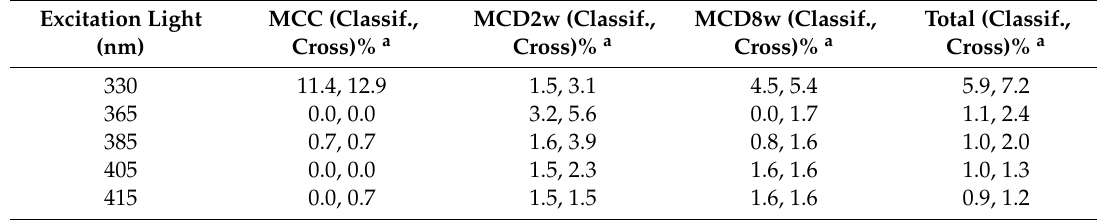
a Error rate, in percent, expressed for (classification, cross-validation)